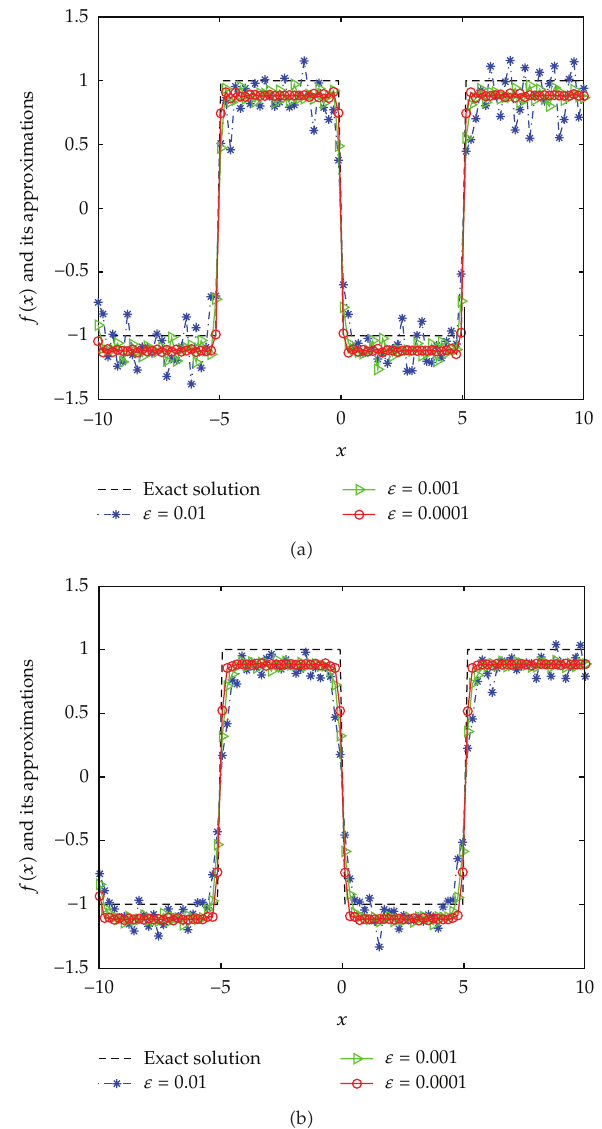
Figure 3: . Comparison between the exact solution and its computed approximations with various levels of noise for Example 4.3: (cid:5) a (cid:6) p (cid:7) 1, (cid:5) b (cid:6) p (cid:7) 2. second-order numerical di ff erentiation, we obtain the same error estimate 2 δ p/ (cid:5) p (cid:8) 2 (cid:6) E 2 / (cid:5) p (cid:8) 2 (cid:6) (cid:5) 1 (cid:8) (cid:5) 2 − p (cid:6) / (cid:5) p (cid:8) 2 (cid:6) } (cid:6) . According to (cid:3) 26 (cid:4) , this H¨older-type error estimate is order 1 / 2 max { 1 , (cid:5) δ/E (cid:6)